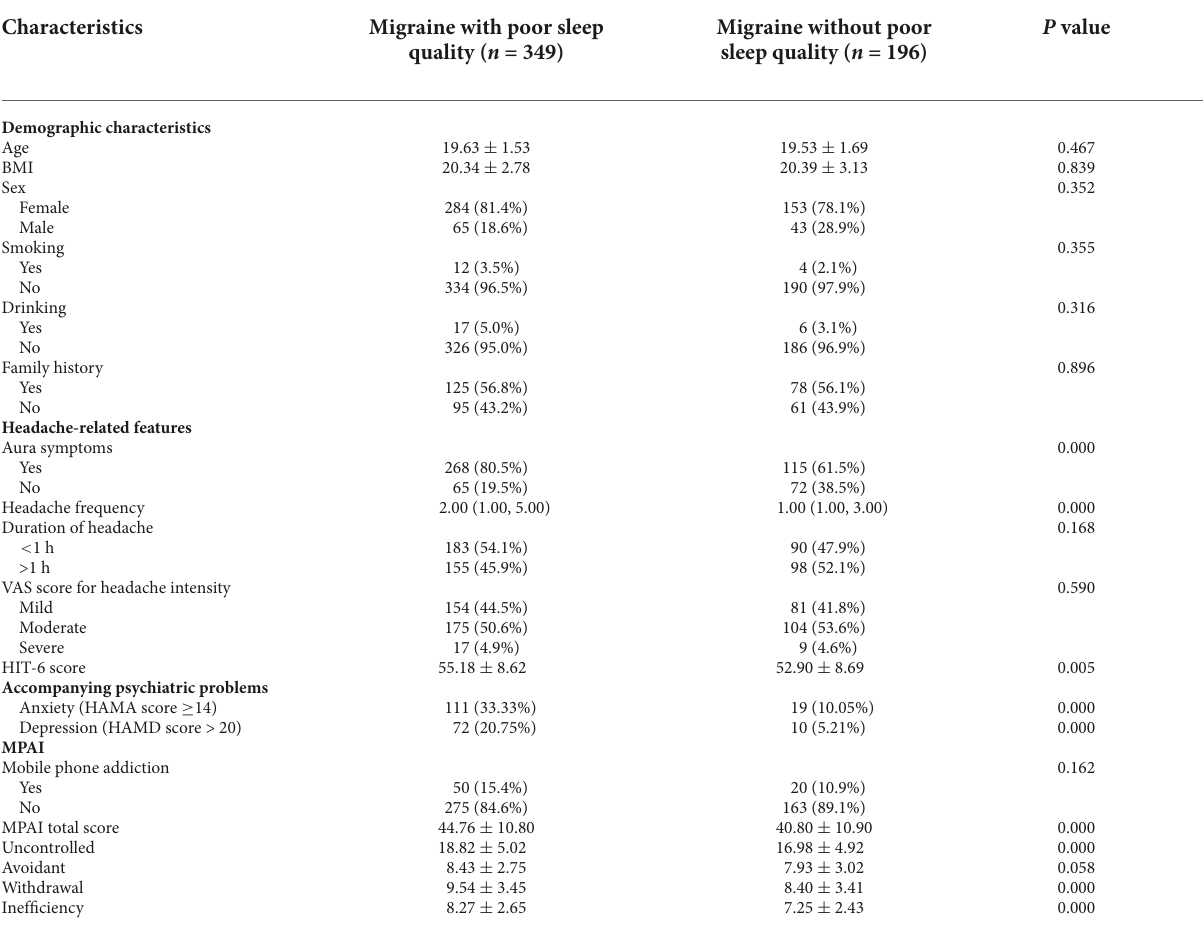
TABLE 1 Sociodemographic characteristics of surveyed participants.